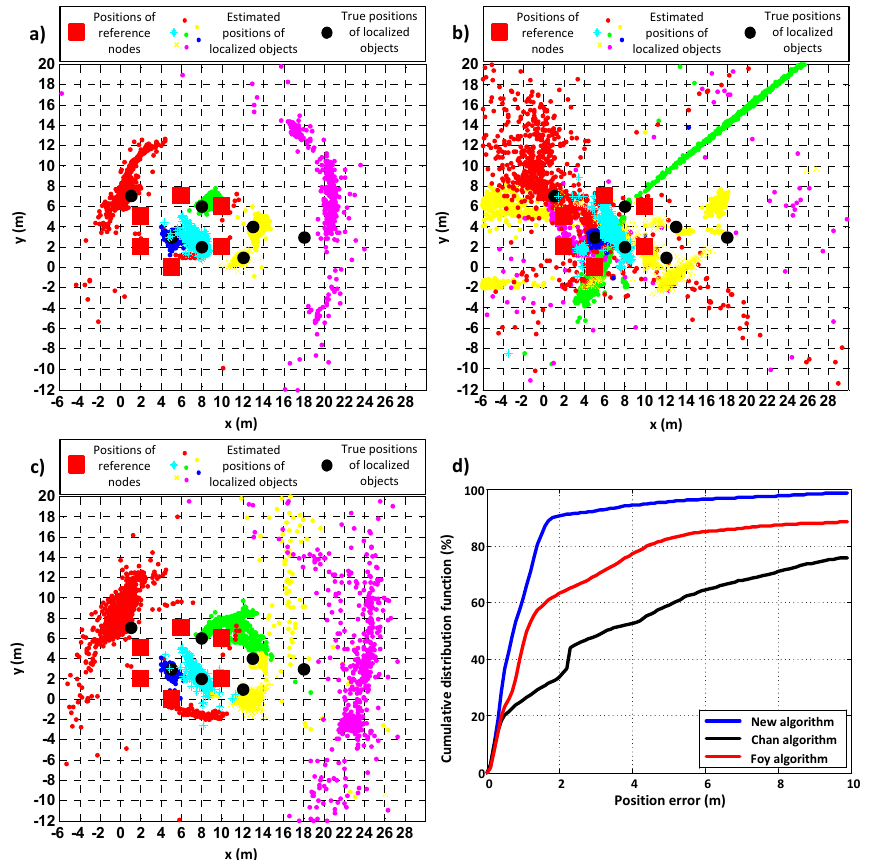
Figure 8. Comparative analysis of the performance of ( a ) the new algorithm, ( b ) the Chan algorithm, ( c ) the Foy algorithm, and ( d ) the cumulative distribution functions of position errors when all devices were deployed within one corridor with poor geometry. Table 3. Results of comparative analysis when all devices were deployed within one corridor with poor geometry.